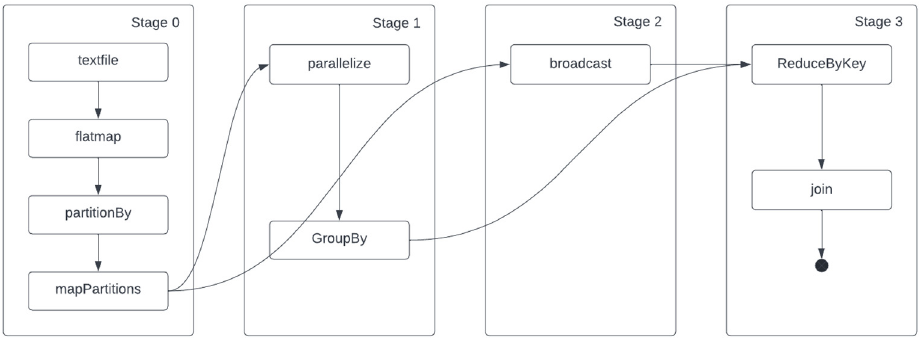
Figure 3. DAG depicting the physical execution plan of the distributed FCM.